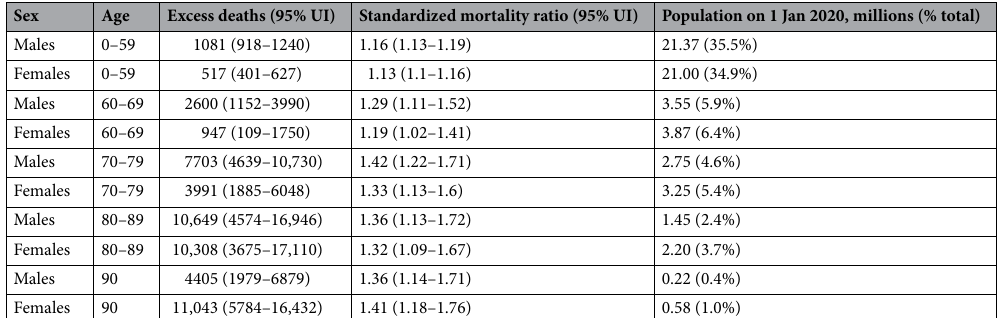
Table 1. Estimated excess mortality by age and sex grouping, aggregated to the national level for the weeks of 26 February through 26 May 2020. Nationally, all age-sex groupings experienced significantly elevated mortality compared to the expected baseline during this